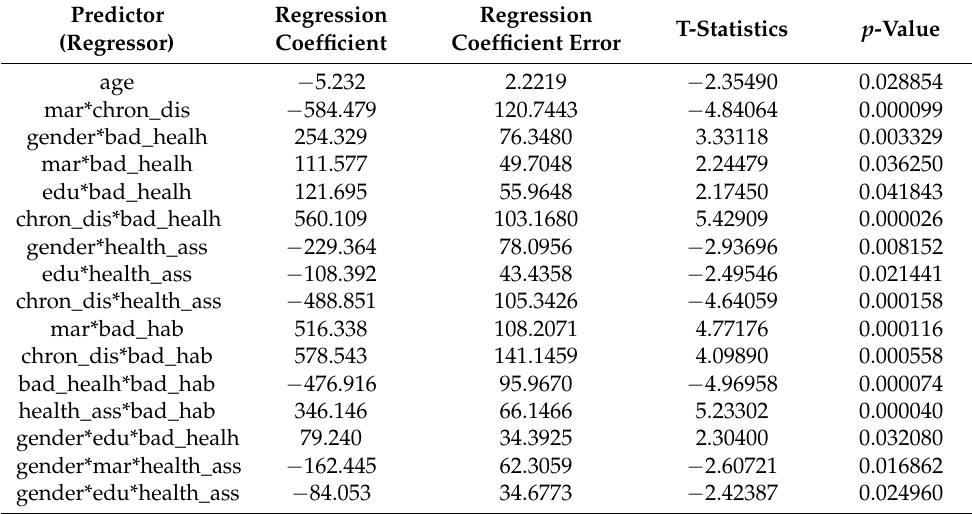
Table 4. Regression results for labor productivity modeling (only significant regressors are included).